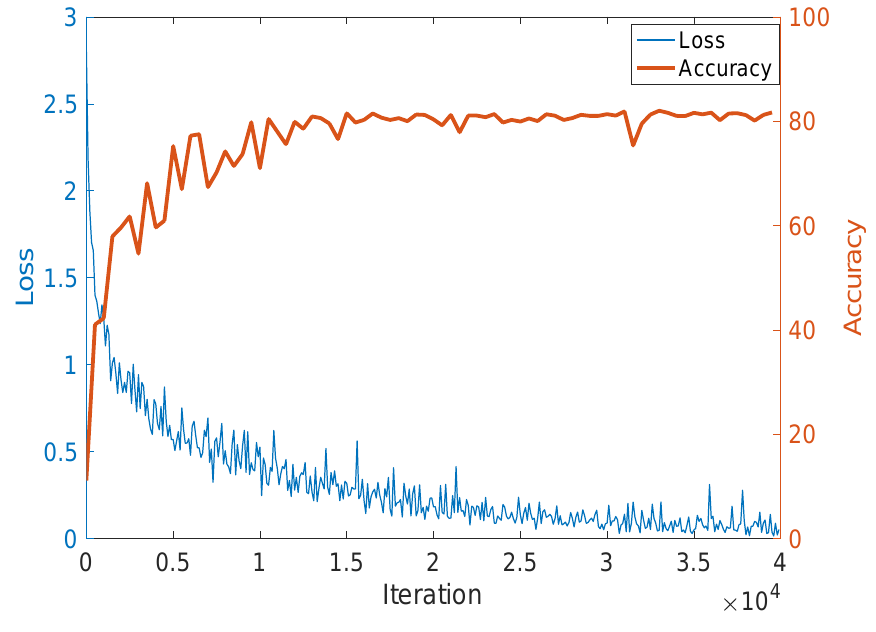
Figure 6. Learning curve for the classification model.